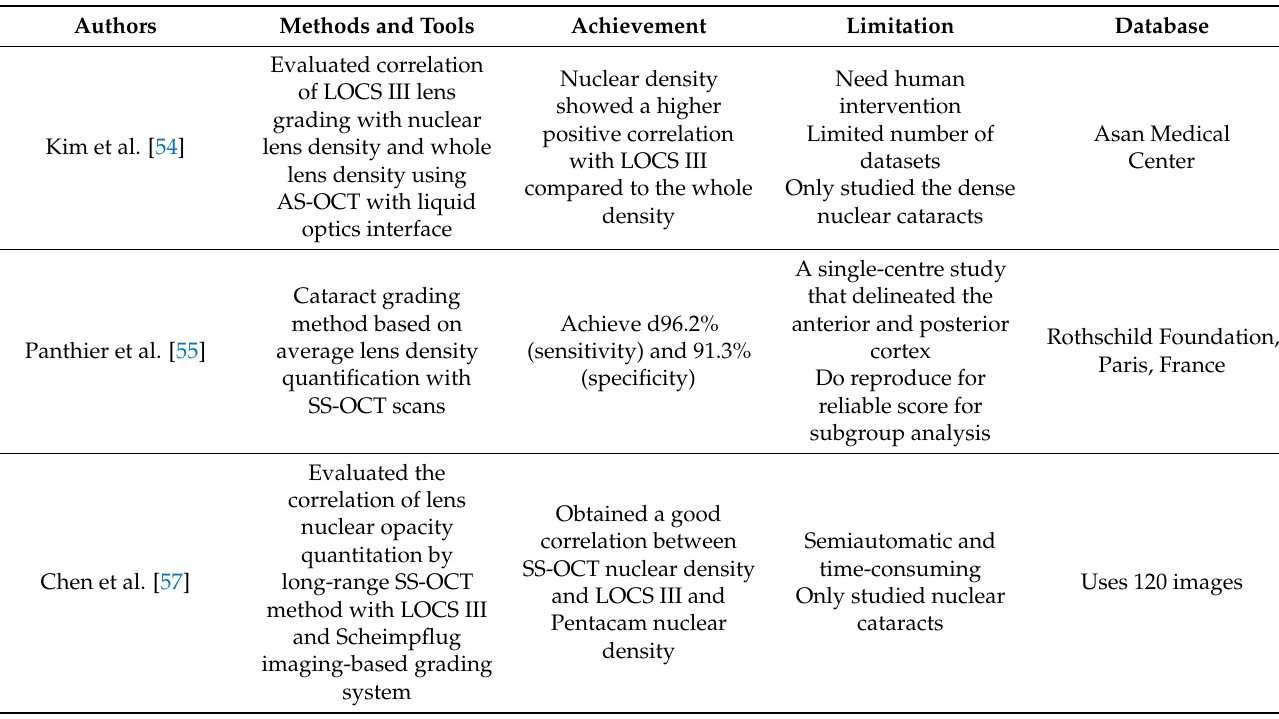
Table 3. Available Tools for Cataract